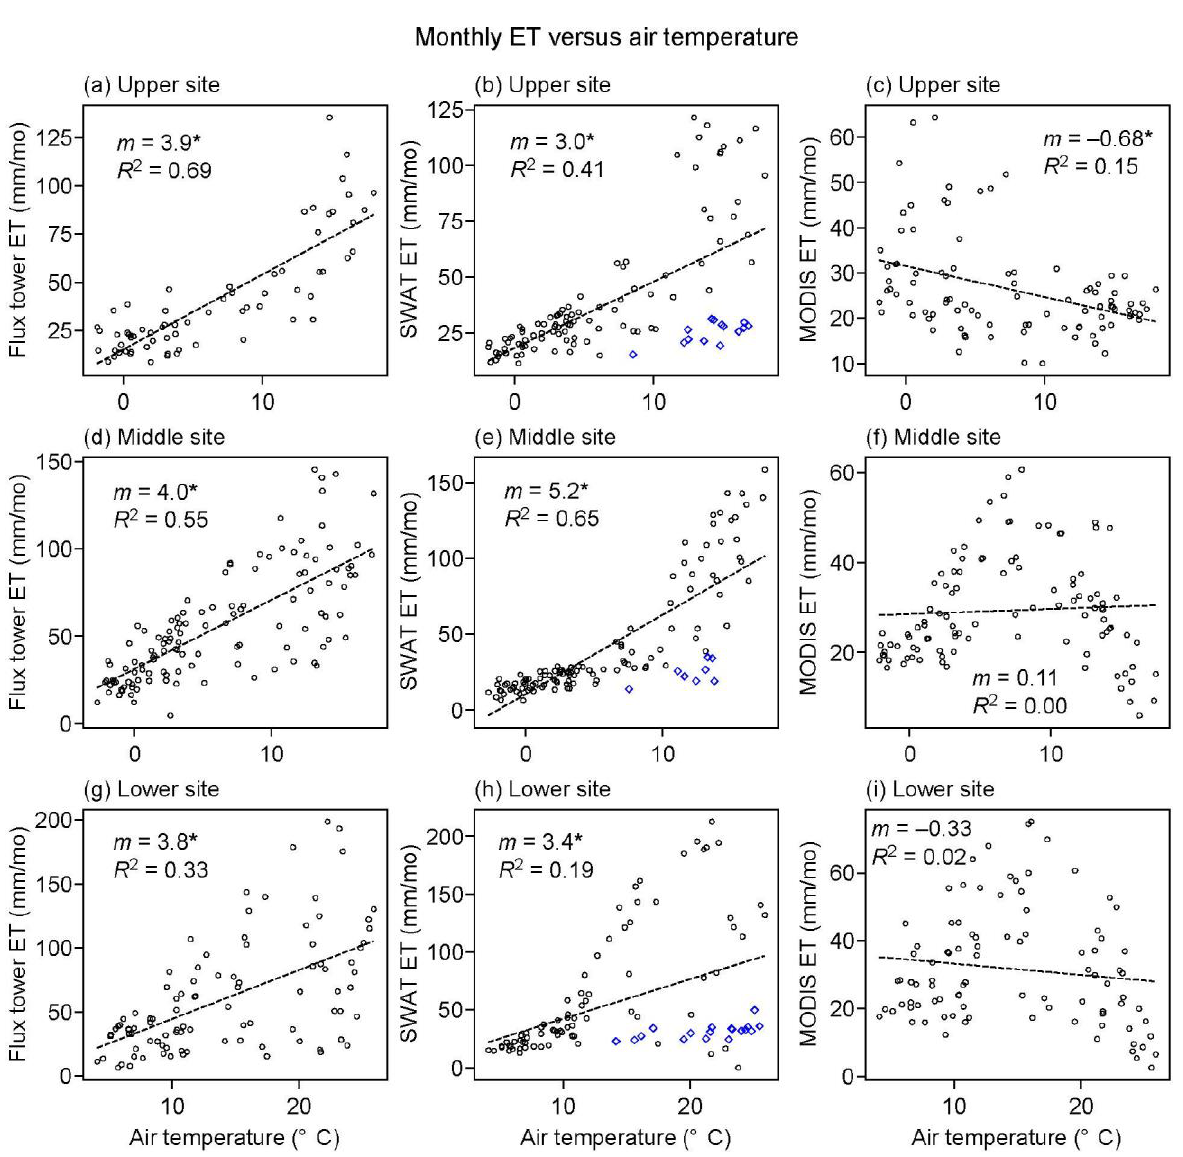
Figure 6. Monthly ET versus air temperature from different data sources at the ( a – c ) upper site, ( d – f ) middle site, and ( g – i ) lower site. Dashed lines are best fits from linear regression. m = slope of regression best-fit with asterisk where p -value < 0.05, R 2 = coefficient of determination of best-fit. In center column, SWAT modeled ET supplied primarily by aquifer water (“revap” flux) are plotted as blue-colored diamond symbols.